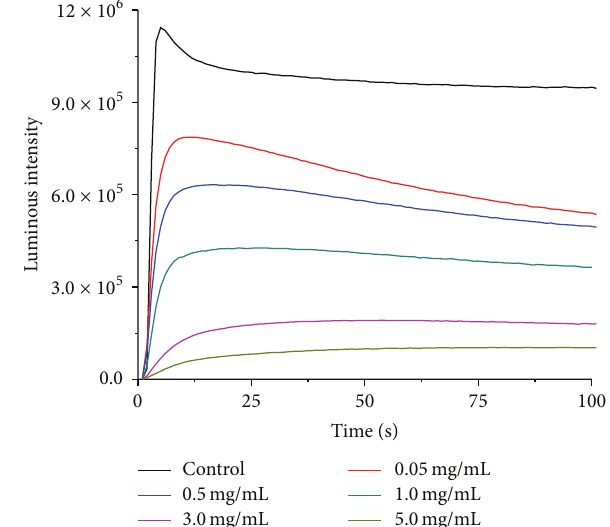
Figure 3: Inhibition of different concentrations of ophiurasaponin to hydrogen peroxide: 0.05 mg/mL, 0.5 mg/mL, 1mg/mL, 3 mg/mL, and 5